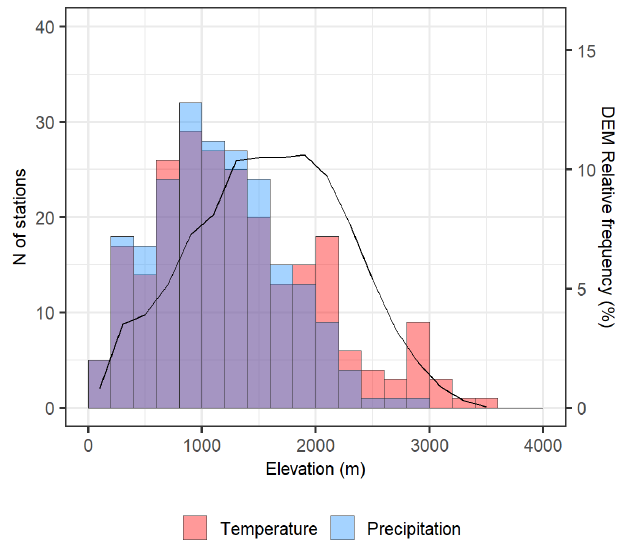
Figure 3. Elevation distribution of temperature and precipitation stations in absolute numbers over 200m bins (left axis). The relative elevation distribution of the 250m digital elevation model covering the study domain is reported on the secondary y axis for the same 200m